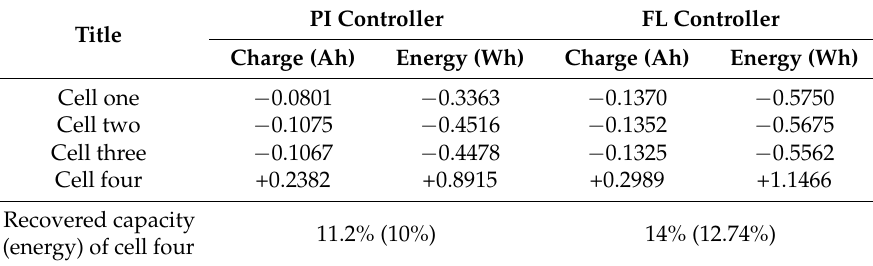
Table 4. Balancing Results for the NCA Battery